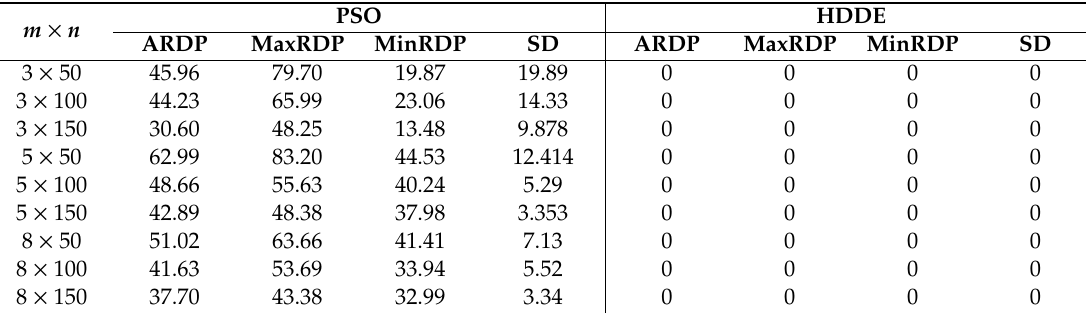
Table 9. Comparison between HDDE and